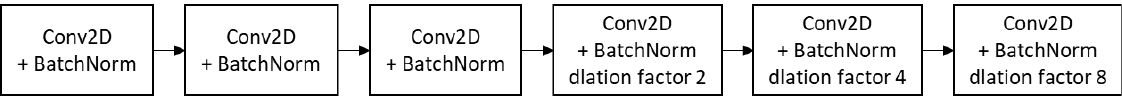
Figure 6. Stratigraphic seismic slice extracted at the time −1 034 ms ( a ) and the corresponding label ( b ). Interpretation was done by interpreters at RIPED. Though there is uncertainty associated with labels, especially where the faulted zone and channels overlap, the goal of this work was to test the supervised algorithm, so human interpretation uncertainty was not taken into account.